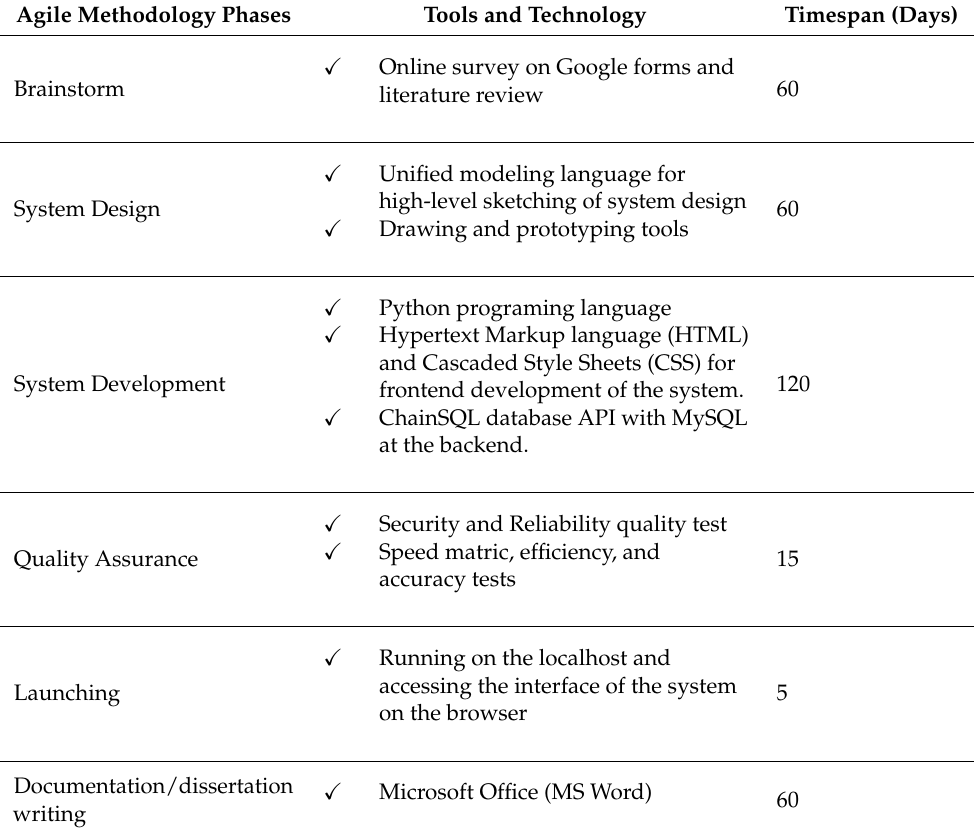
Table 1. Connection of agile methodology with the proposed decentralized freelancing system. Agile Methodology